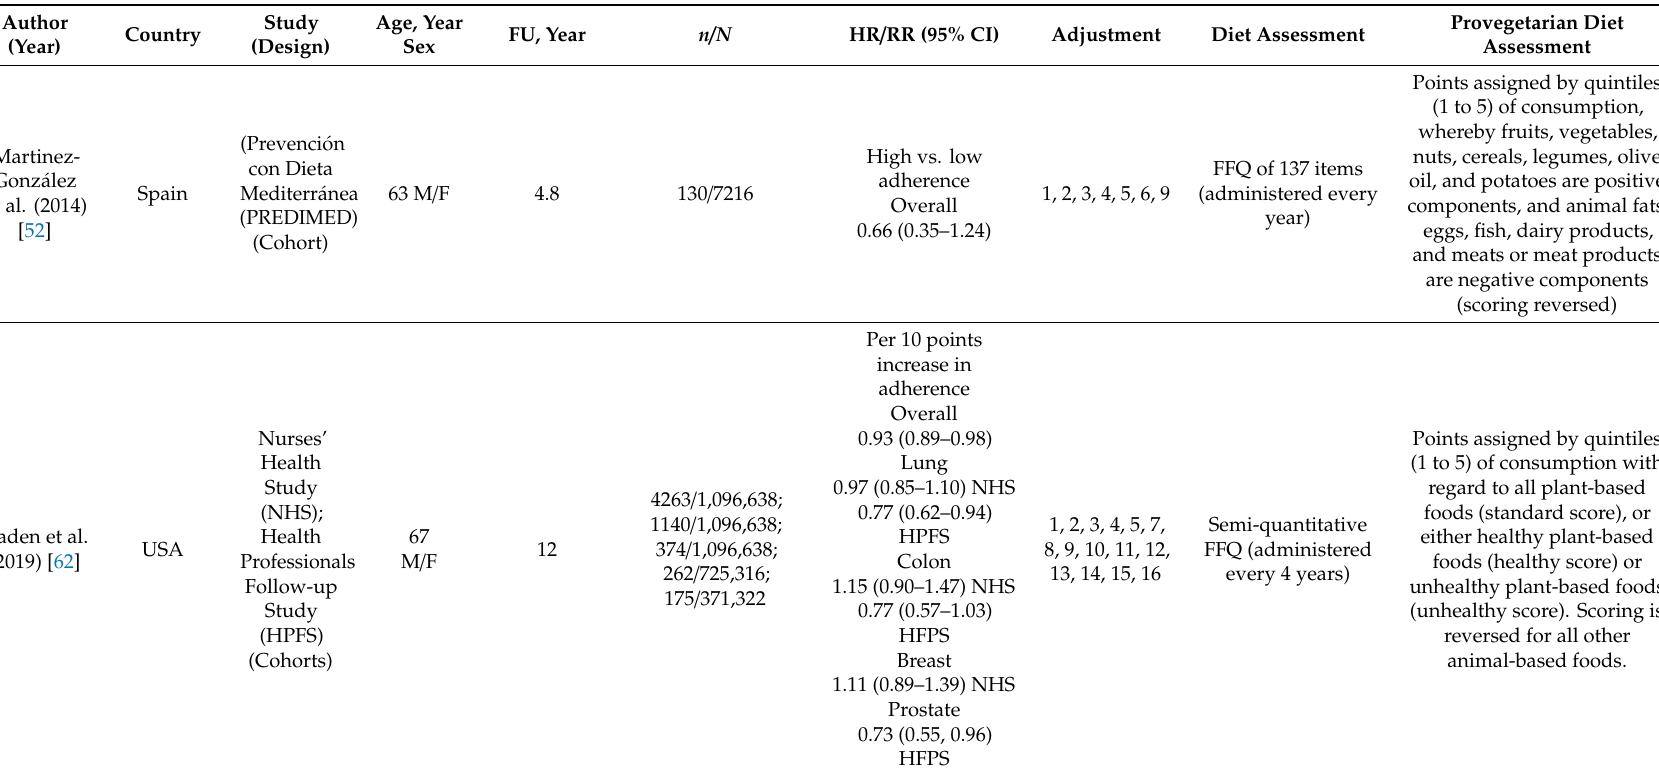
Table 2. Characteristics of the studies evaluating provegetarian diets and cancer mortality including cause-specific cancer